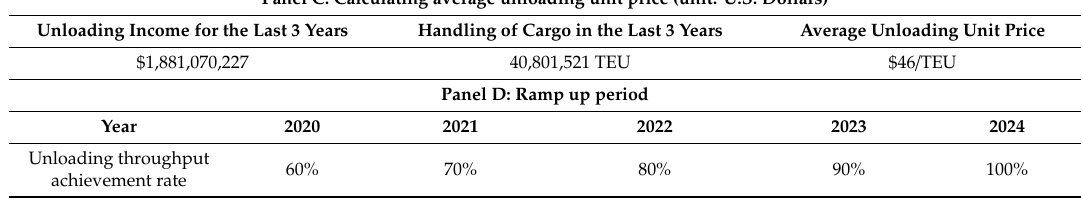
Panel C: Calculating average unloading unit price (unit: U.S. Dollars)